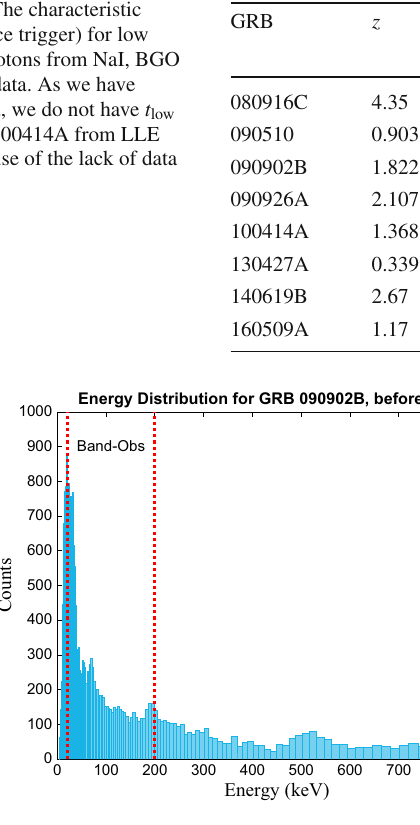
Fig. 14 The energy distributions of Set-NaI photons of GRB 090902B within [− 20 , 0 ] s and [ 0 , 20 ] s since trigger. The red dashed lines mark